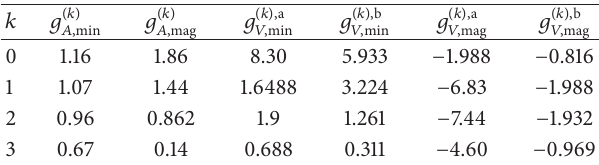
Table 2: Numerical results for axial and vector meson couplings in the noncritical holographic model of QCD. The values of vector couplings are compared with the SS model results [37].